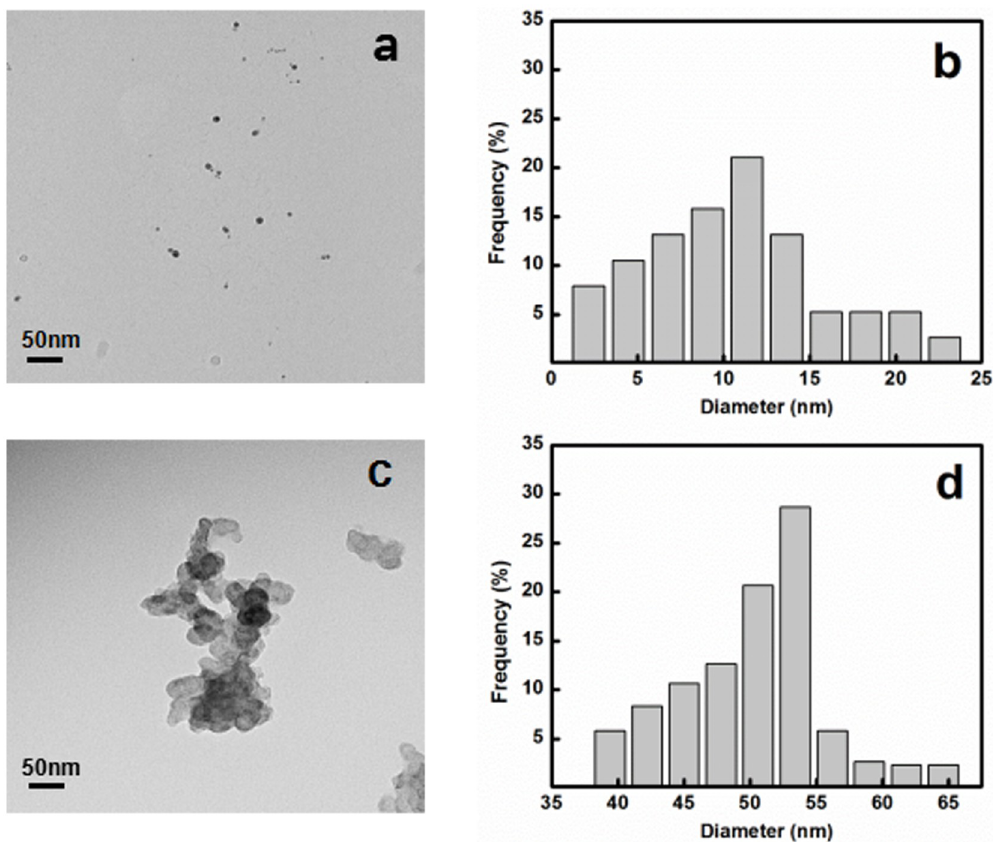
Fig 1. The characterization of different sizes of silver nanoparticles by TEM. TEM images of (a) nano-Ag 10 and (c) nano-Ag 50. Frequency of size distribution for (b) nano-Ag 10 and (d) nano-Ag 50; scale bar: 100nm.